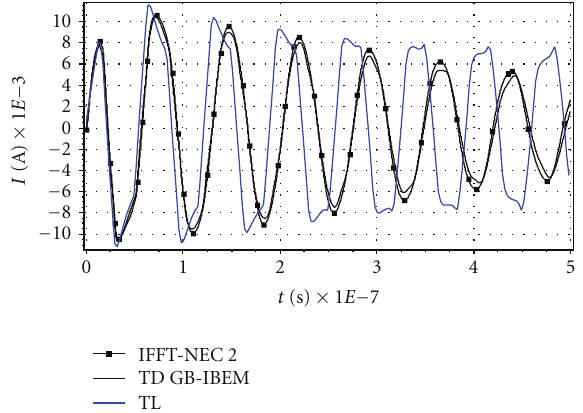
Figure 15: Transient current induced at the center of wire 2 (Geometry No. 1)—comparison between IFFT-NEC2, TD GB- IBEM and TL results.